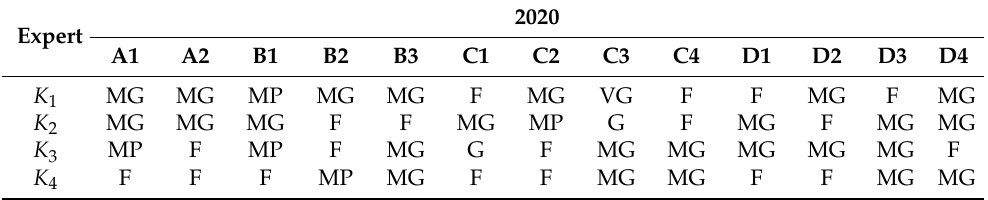
Table 13. Resilience rating scale of Shaanxi Province coal industrial chain and supply chain (2020).